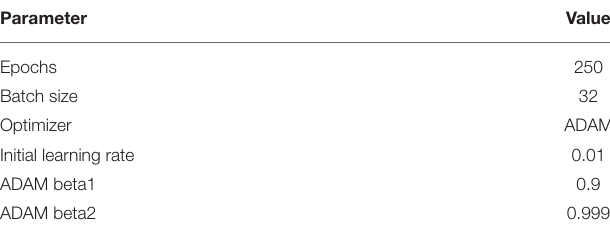
TABLE 2 | Training parameters of the auditory